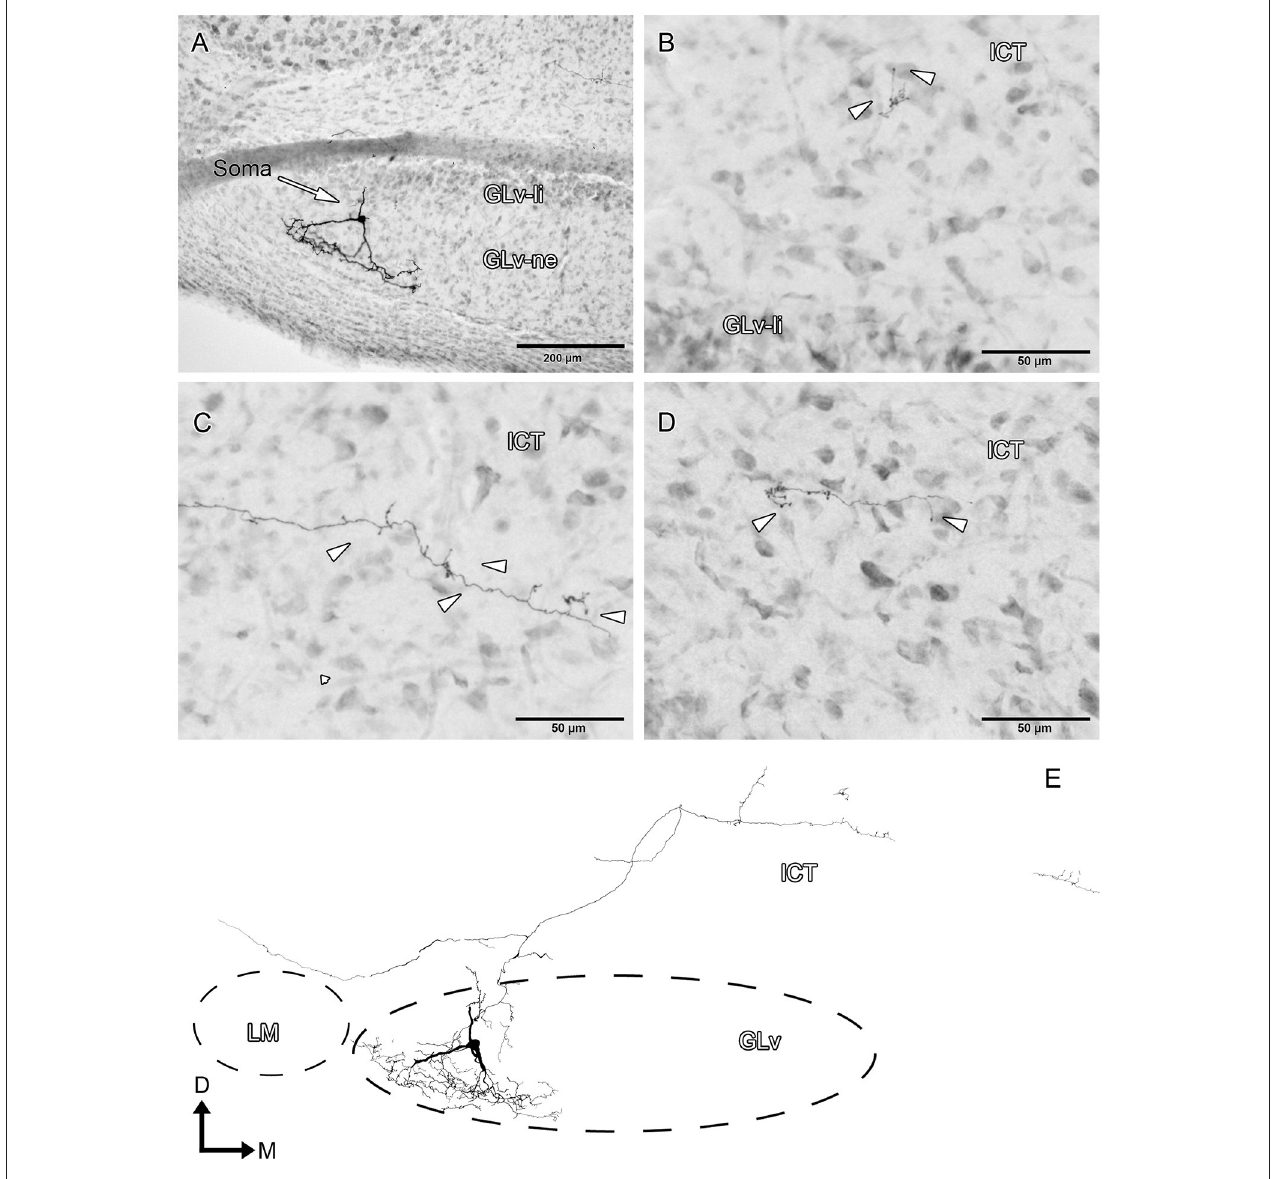
FIGURE 7 | Intracellular filling of a representative GLv-ne type V cell. (A–D) Photomicrographs showing the soma location, dendritic processes, medial axon and terminal ending in ICT. Arrowheads indicate the different neuronal processes. (E) Reconstruction of the biocytin-filled neurons. D, dorsal; M, medial. Orientation in (E) applies to (A–D)